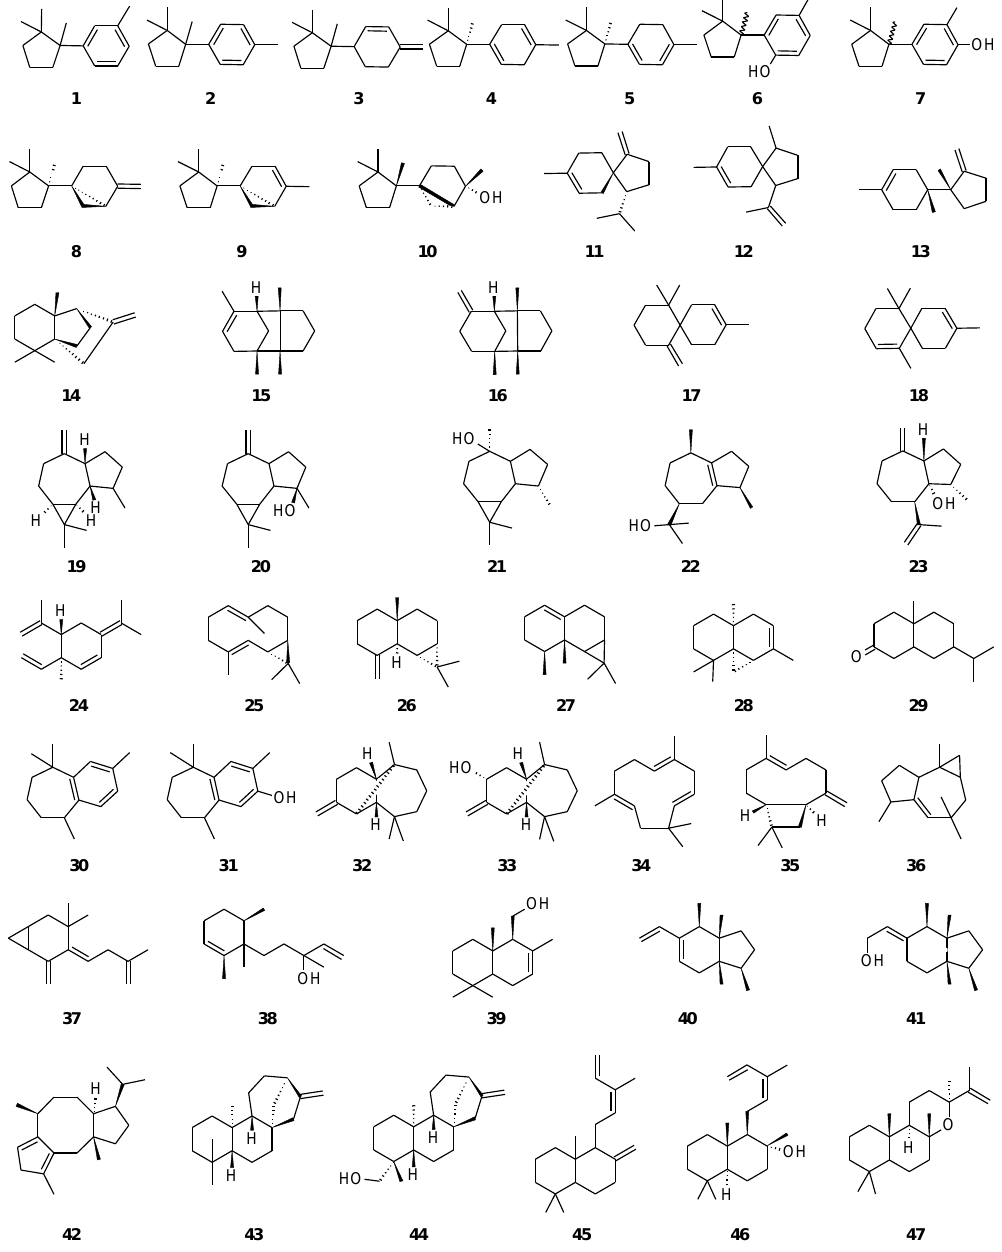
Figure 2. Selected compound structures detected in the studied species.